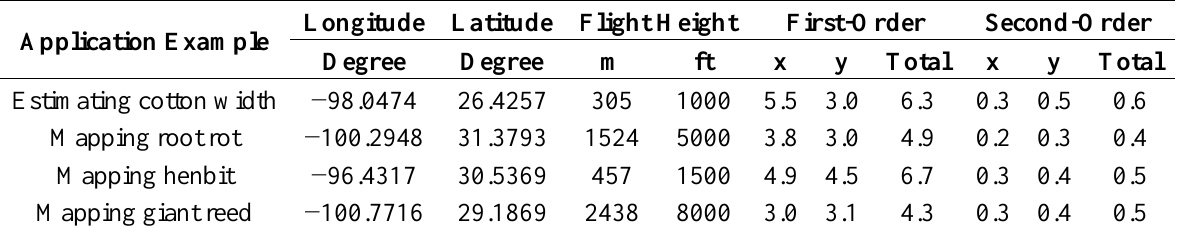
Table 4. Geographic coordinates, flight heights above ground level, and root mean square errors in pixels for registering near-infrared band images to normal color images acquired from four different study sites using the first- and second-order transformations based on nine control